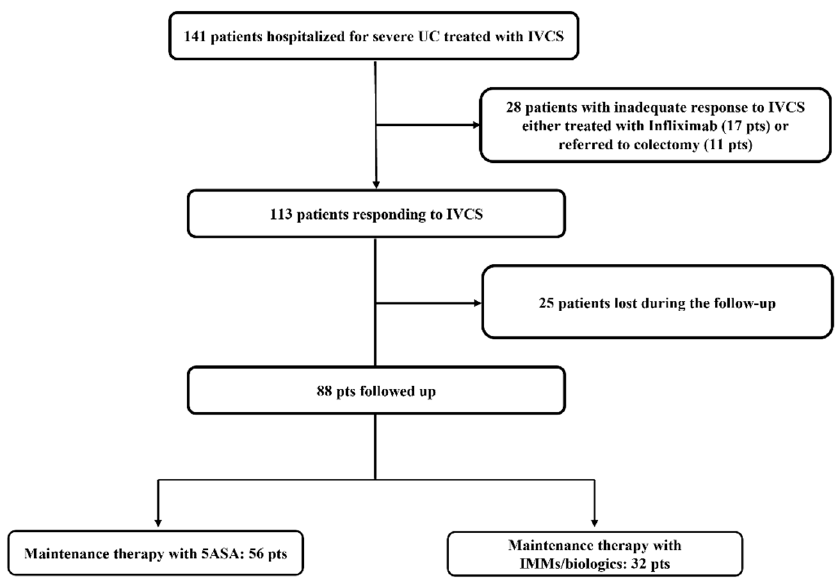
Figure 1. Flow-chart of patients with acute severe ulcerative colitis (UC) admitted to the hospital and initially treated with intravenous corticosteroids (IVCS). 5-ASA = 5-aminosalycilic acid; IMMs = immunosuppressors.